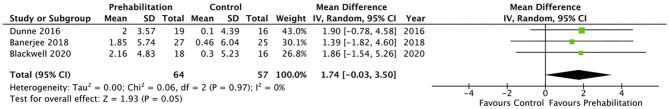
Meta-analysis of change in oxygen consumption (VO2) at peak (ml per kg per min) after prehabilitation.